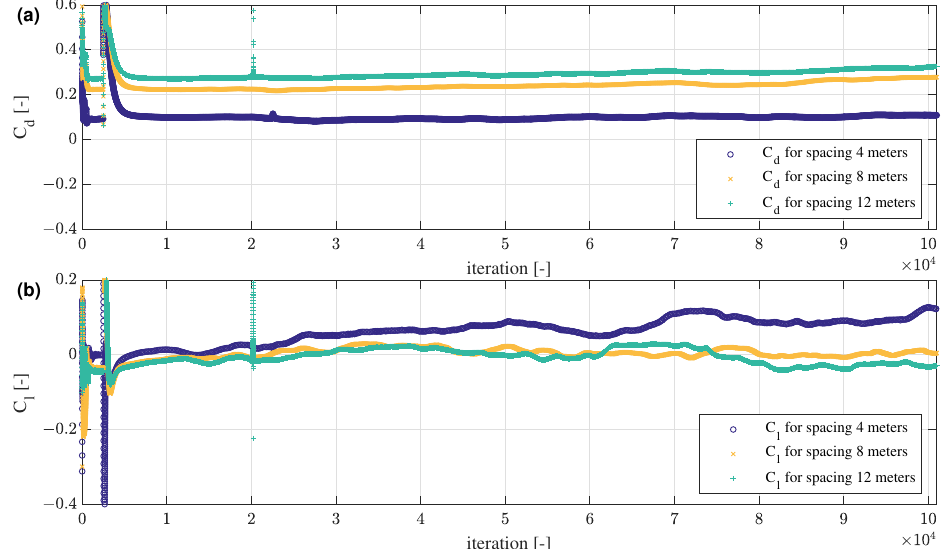
Figure 8. Comparison of the aerodynamic coefficients for heterogeneous columns consisting of three vehicles: van–truck–car. The graph shows data for the first vehicle: van. For the marker: dark blue “o”—the distance between the vehicles is 4 m, orange “ × ”—the distance between the vehicles is 8 m, teal “+”—the distance between the vehicles is 12 m. ( a ) Drag coefficient. ( b ) Lift coefficient.